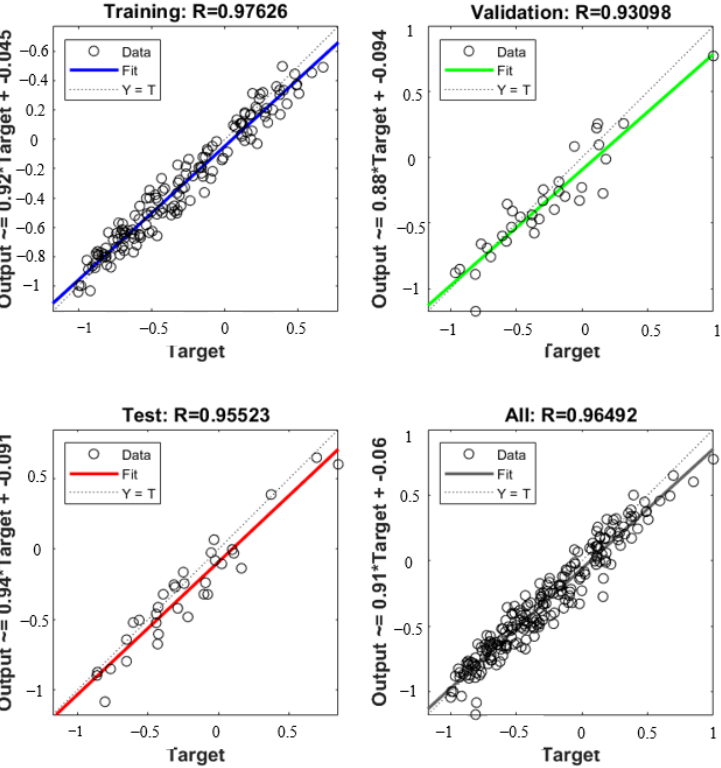
Figure 7. Correlation between training set and test set of BP neural network model.